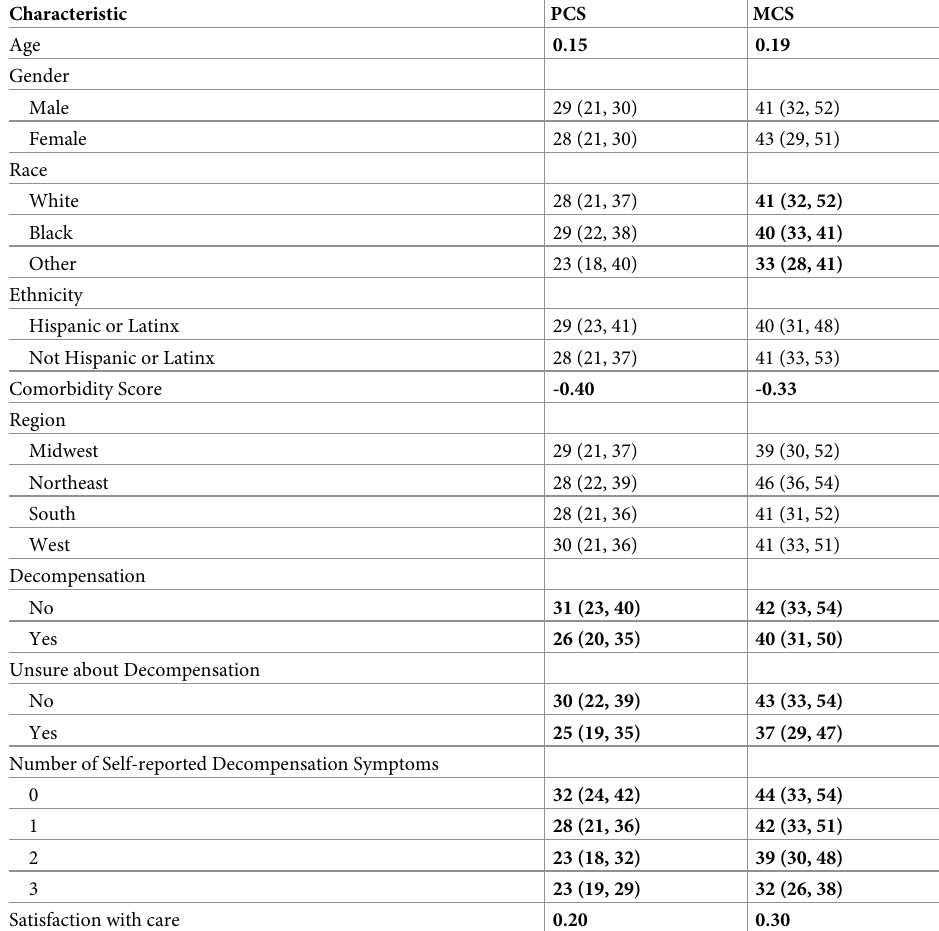
Table 3. Associations between respondent characteristics and